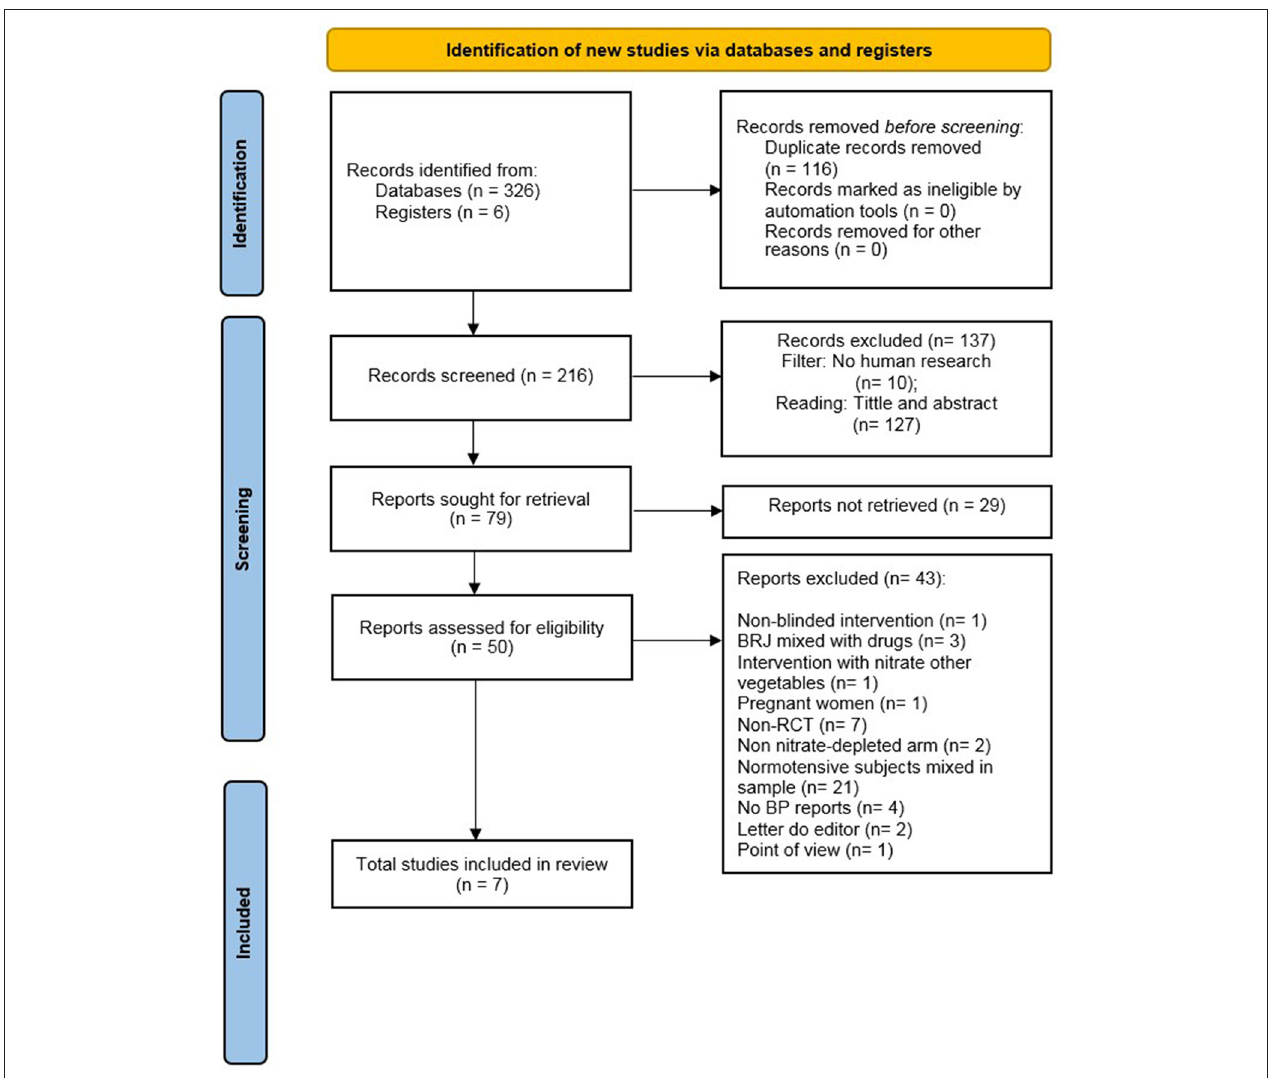
FIGURE 1 | Flowchart